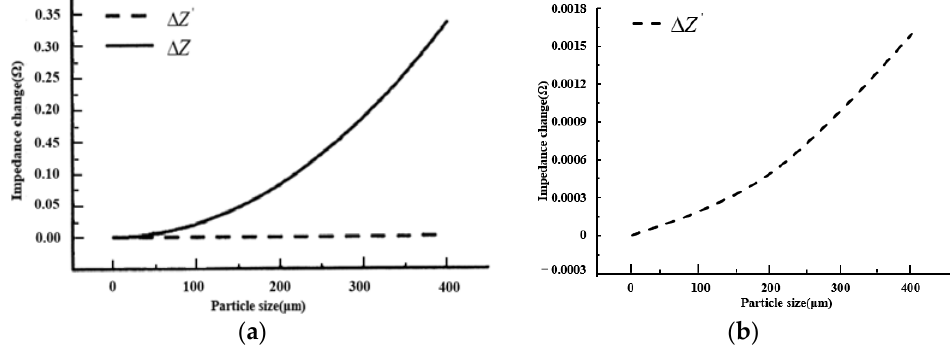
Figure 3. Test results. ( a ) Result comparison; ( b ) enlarged view.